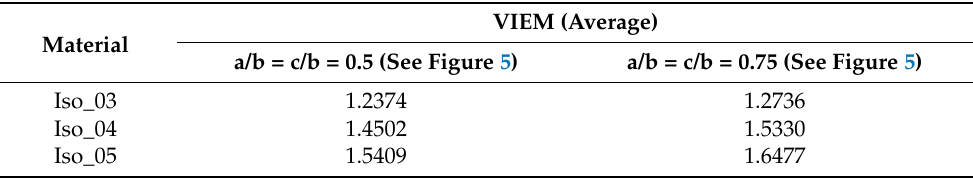
Table 11. Normalized tensile stress component ( σ xx / σ o xx ) within the isotropic prolate spheroidal inclusion due to uniform remote tensile loading ( σ o xx ).